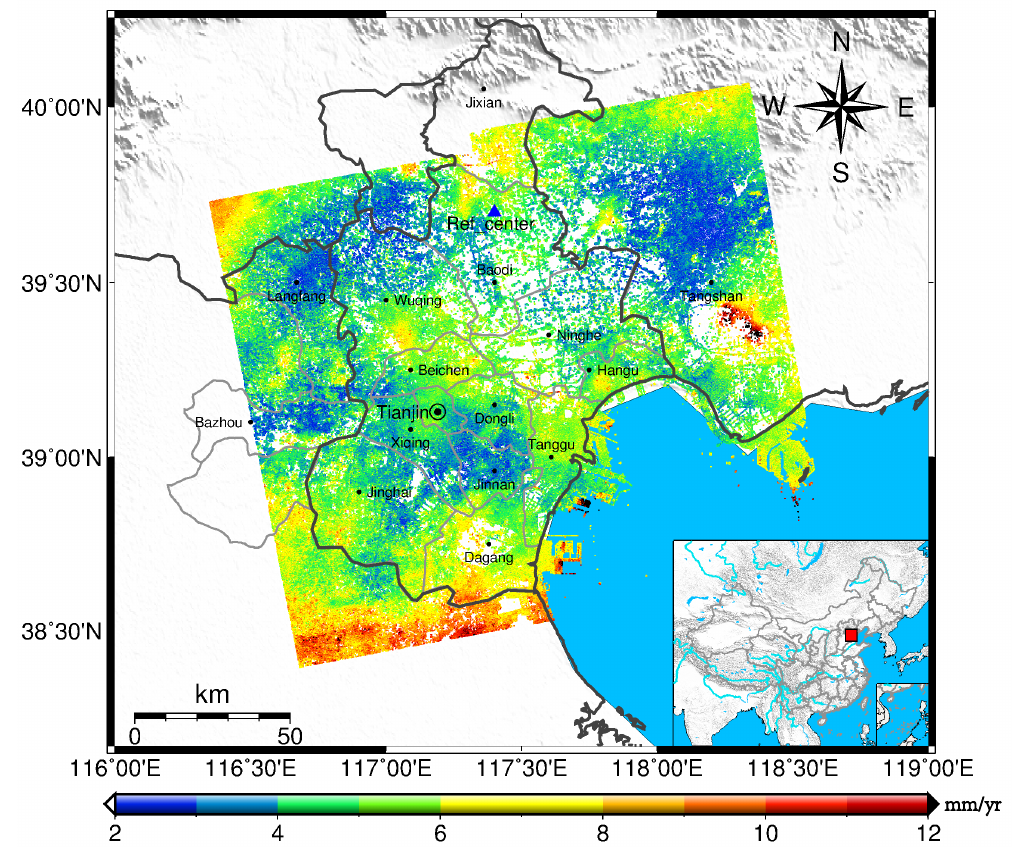
Figure 6. Distribution of the standard deviation of the velocity for PS points in the direction of LOS. Table 2. Statistics table for the calculated temporal